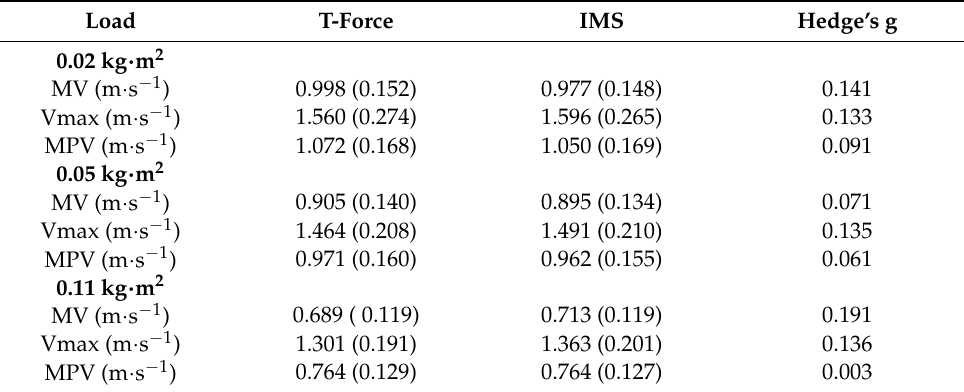
Table 1. Mean concentric velocity (MV), maximum velocity (Vmax) and mean propulsive velocity (MPV) at three different flywheel loads (0.02 kg · m 2 , 0.05 kg · m 2 , 0.11 kg · m 2 ) measured by the T-Force and IMS, and Hedge’s g effect size between T-Force and IMS. All data are presented as mean (SD) of 31 participants.